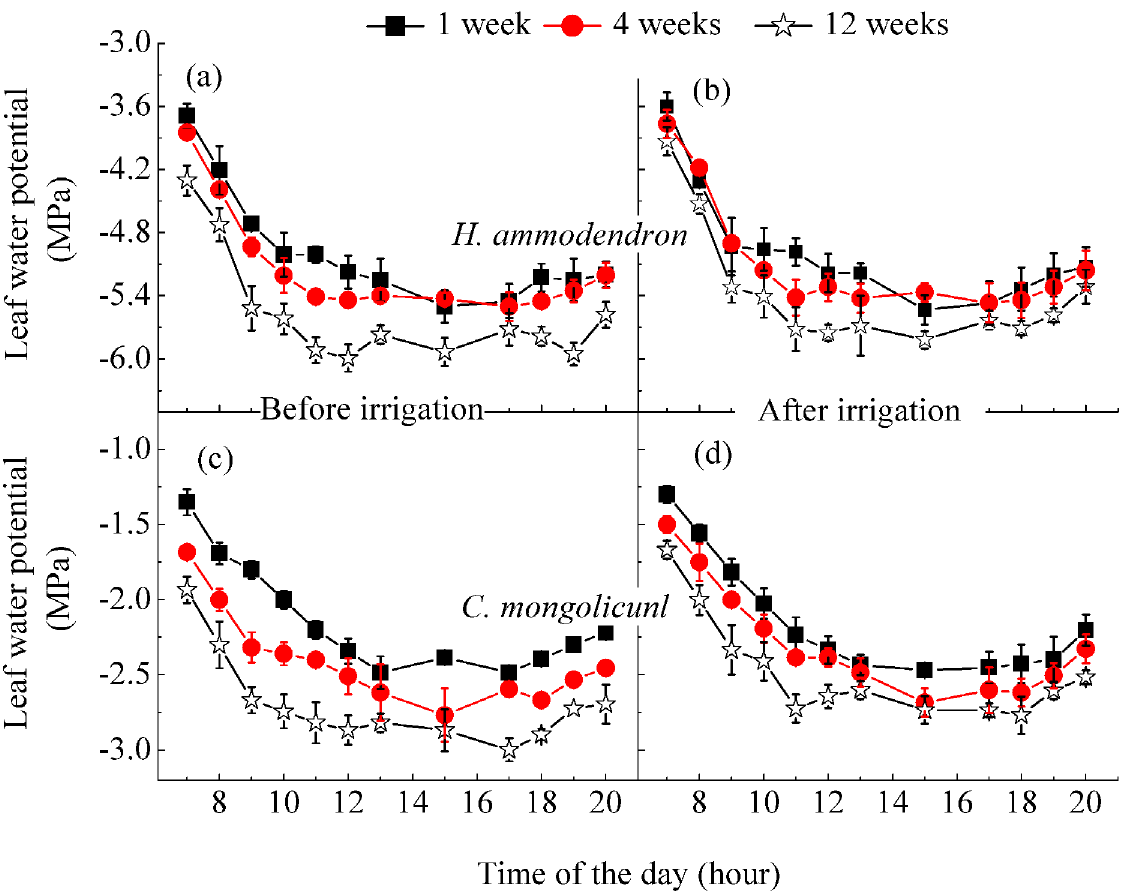
Fig 4. Diurnal pattern of leaf water potential of H . ammodendron (a, b) and C . mongolicunl (c, d) before and after irrigation for the five irrigation intervals. The data points for the 2-week interval fell between those of the 1 and 4 weeks; those of the 8-week intervalfell between those of 4 and 12 weeks. Error bars represent the standarddeviationof the mean.